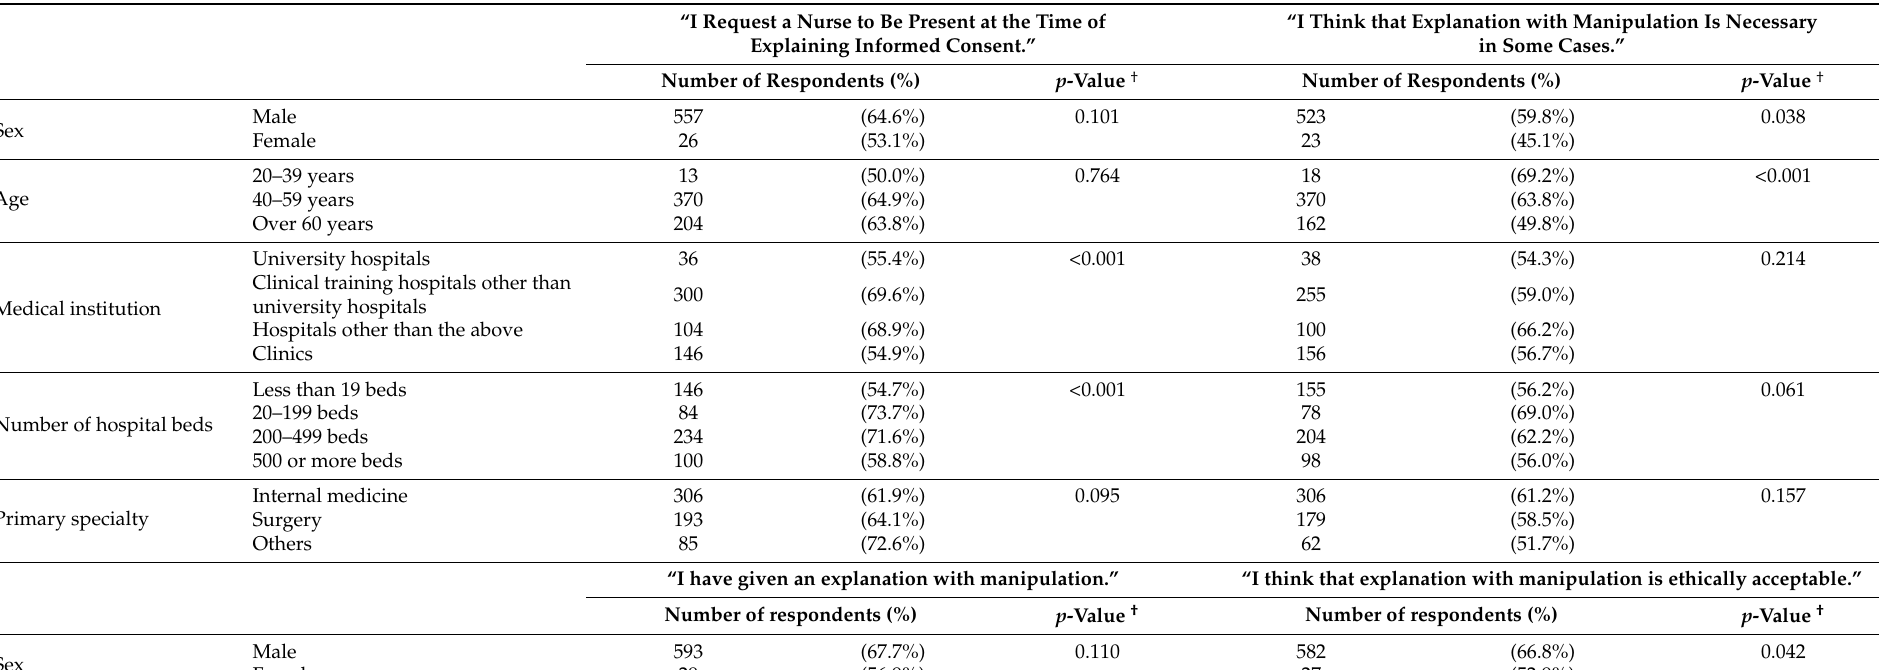
Table 2. The presence of a nurse and the awareness and action regarding explanation with manipulation by attribute and employing medical institution. “I Request a Nurse to Be Present at the Time of “I Think that Explanation with Manipulation Is Necessary Explaining Informed Consent.” in Some